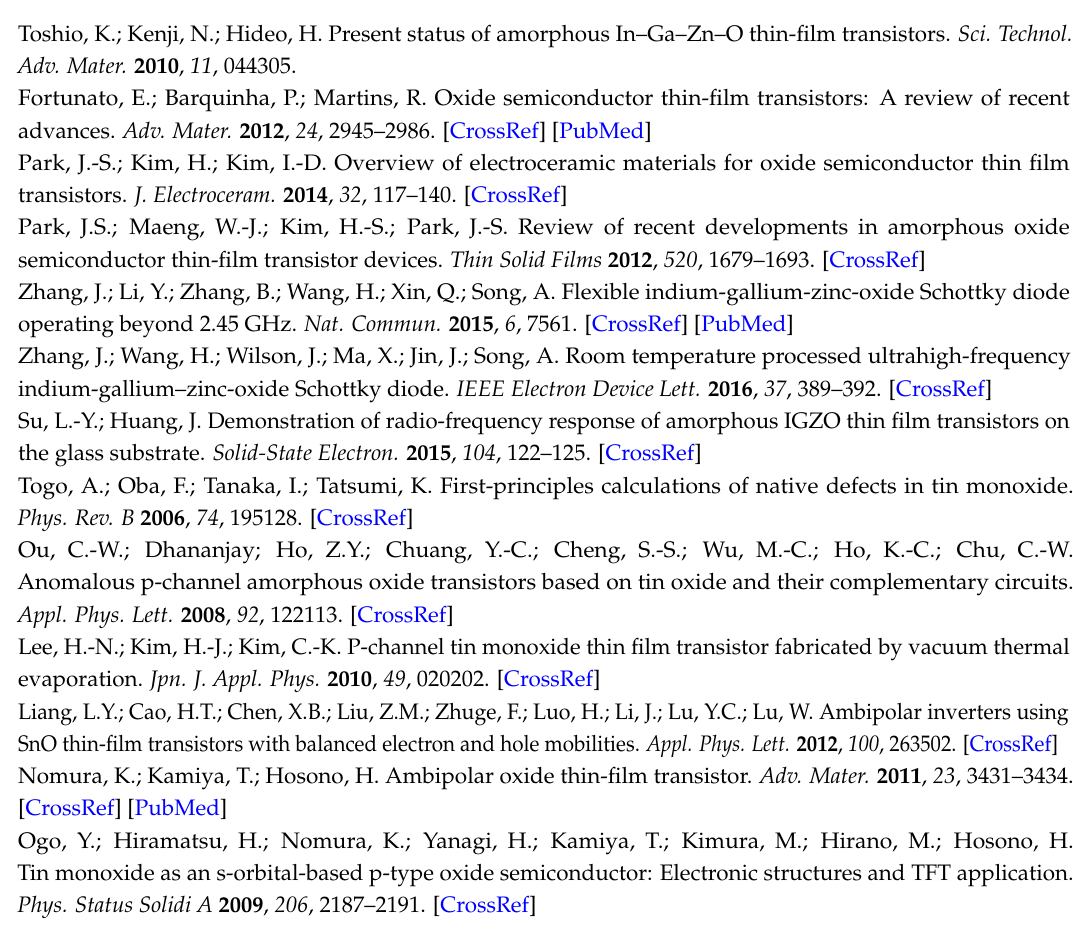
Figure S2. Transfer characteristics of the SnO TFT annealed at 225 ◦ C measured immediately after the fabrication and after six months in air, respectively. Figure S3. SEM image of the as-deposited SnO film. Figure S4. Output voltage and the leakage current of the inverter with V DD = 5